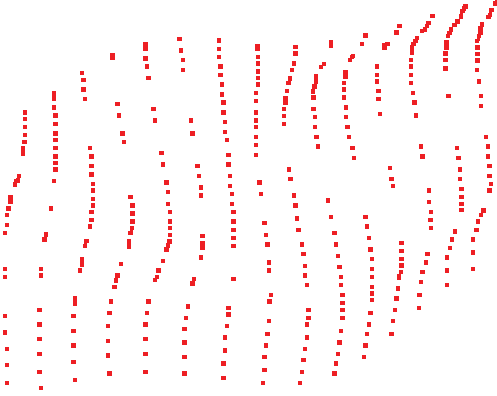
Figure 3: The product has free-form surface features.